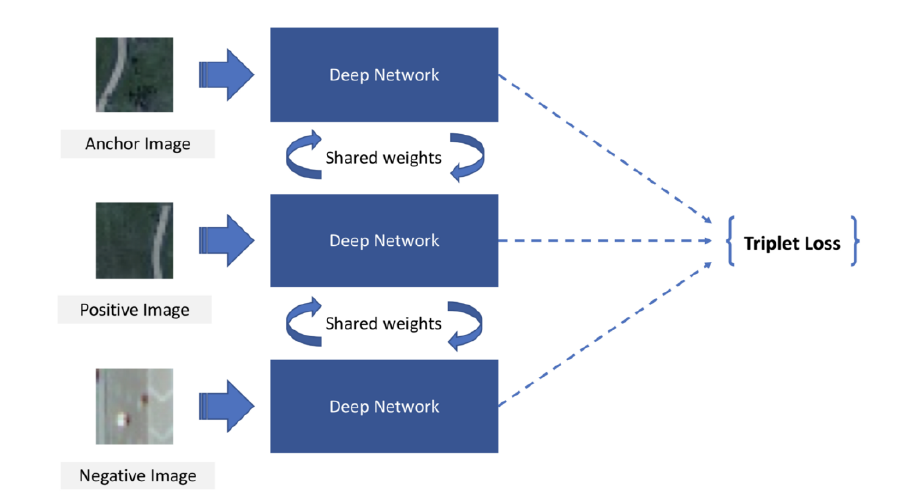
Figure 4: Siamese